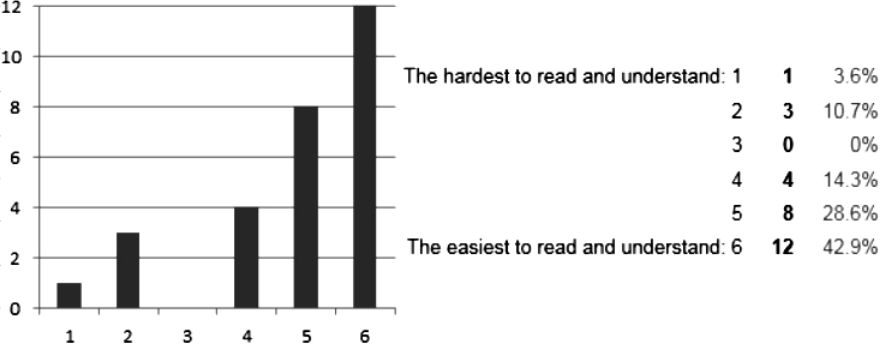
Figure 4. Distribution of marks – AergiaML-like